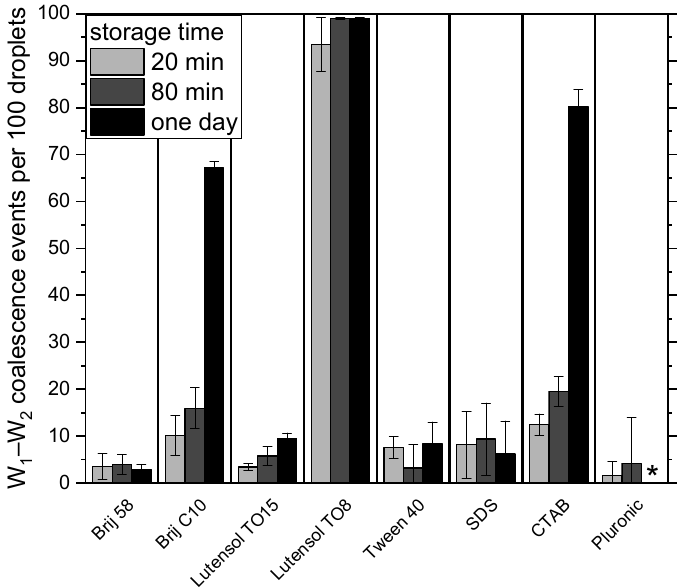
Figure 5. Number of W 1 –W 2 coalescence events, calculated from the number of encapsulated water droplets in each oil droplet. Droplets were stabilized with 0.9 wt% of hydrophilic surfactant in W 2 and 1 wt% of PGPR in O. Most surfactant combinations show good resistance against W 1 –W 2 coalescence, except Brij C10, Lutensol TO8 and CTAB. The last bar (marked with an asterisk) for Pluronic could not be measured, since no oil droplets were left due to O–O coalescence.